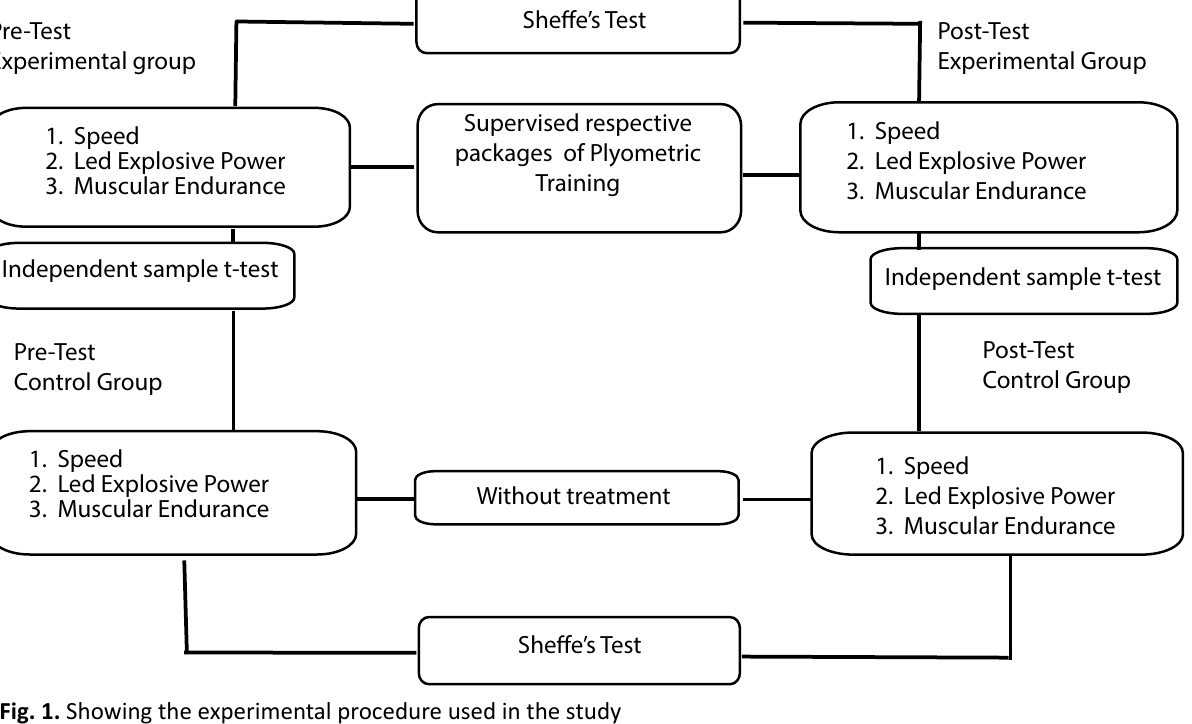
Pre-Test Experimental group